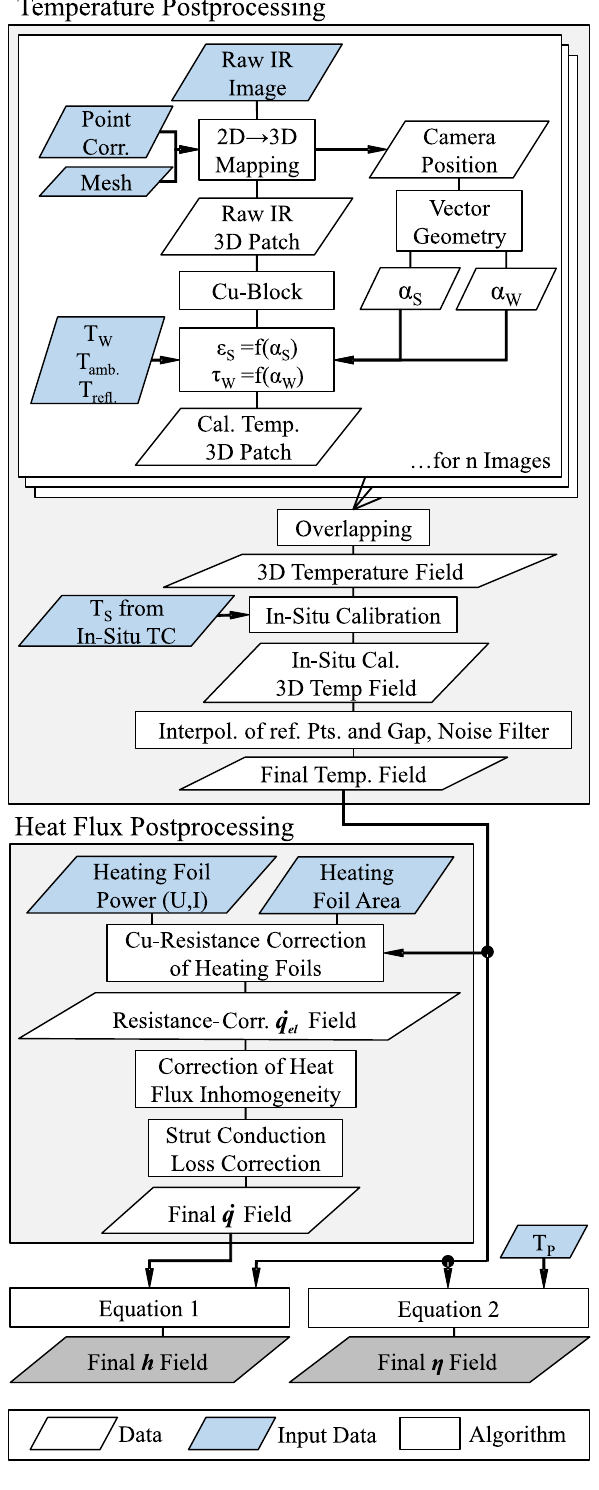
Fig. 3 Main scheme of data reduction, calibration and